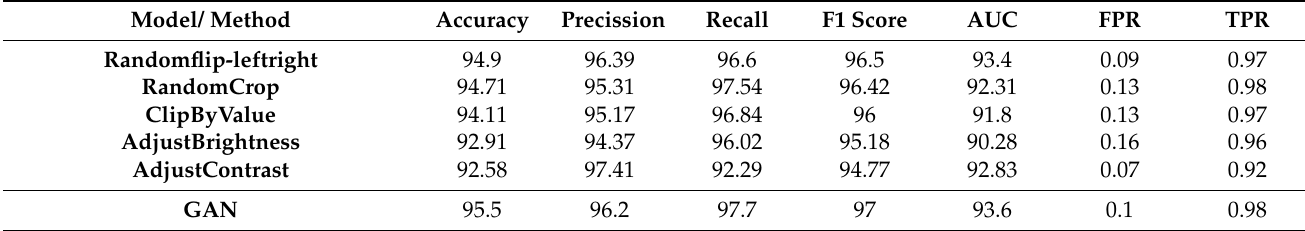
Figure 7. Convolutional Neural Network Architecture. Table 1. Classification performance metrics.